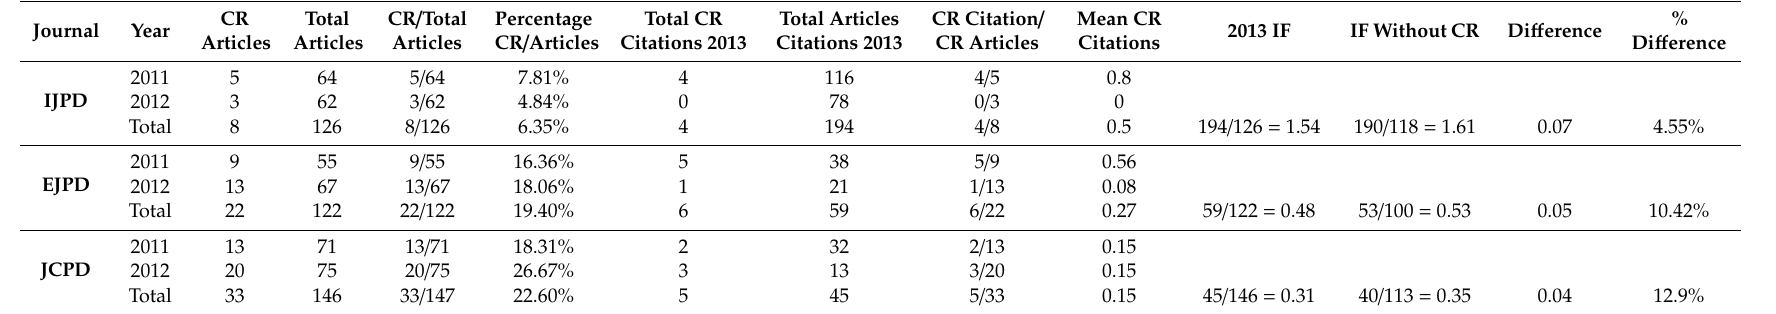
Table 2. CRs in major PD journals and their impact on journal IF.